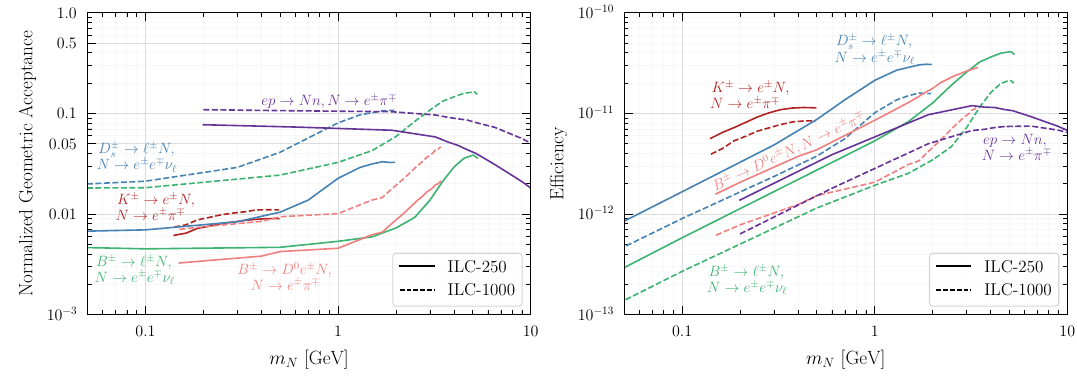
Figure 4 . Left: normalized geometric acceptance as a function of the HNL mass in the long lifetime regime (i.e., having fixed the proper lifetime to 30 seconds) for ILC-250 (solid curves) and ILC-1000 (dashed curves). Right: efficiency as a function of HNL mass. See text for more